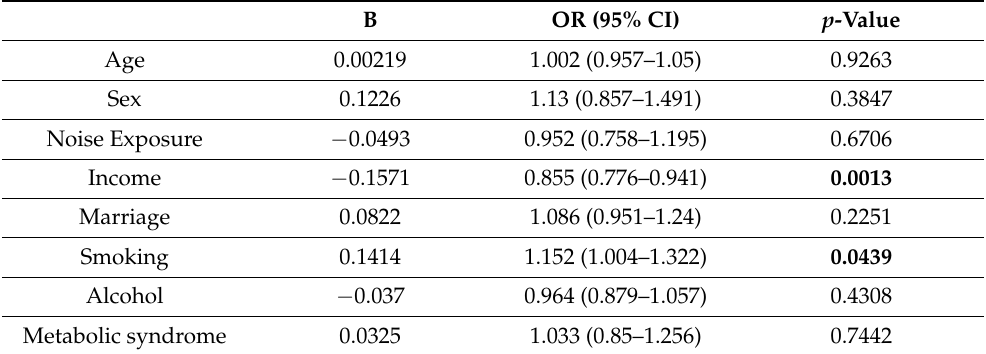
Table 5. Multiple regression models including factors affects hearing